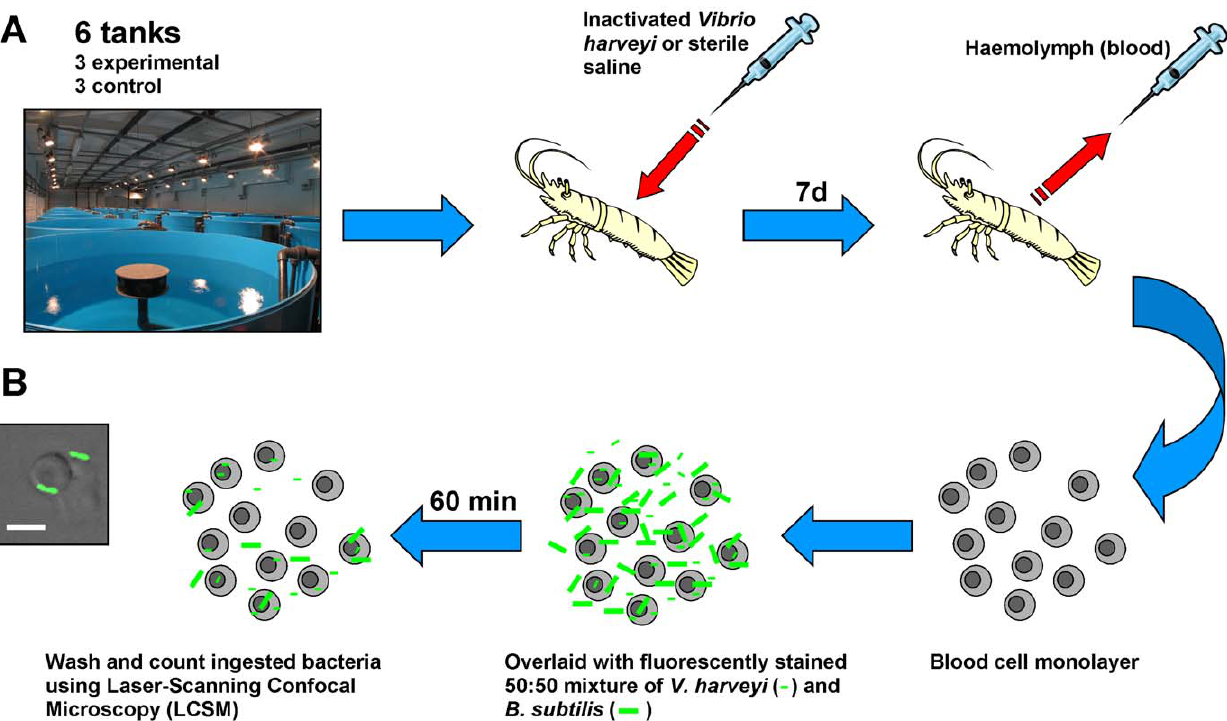
Figure 1. Experimental design for phagocytosis experiments. (A) Schematic diagram of experimental design. Juvenile shrimp ( L. vannamei ) were assigned randomly across 6 6 1500L tanks and injected with either formalin-inactivated Vibrio harveyi (a known shrimp pathogen; 10 8 bacteria animal 2 1 ) or sterile 3% NaCl solution (12–14 animals tank 2 1 , 3 tanks treatment 2 1 ). After 7 d, monolayers of shrimp haemocytes were overlaid with a mixture of fluorescently-labelled formalin-inactivated V. harveyi and an unrelated bacterium ( Bacillus subtilis ; 50:50 mixture). The ability of the haemocytes to phagocytose the different bacteria was then investigated using LSCM. (B) High-power LSCM projection of 15 optical sections through a shrimp haemocyte (total z -axis=10.4 m m) and four FITC-labelled Bacillus subtilis bacteria. Whether an individual bacteria is internalised or not can be determined through sequential viewing of each optical section. Scale bar=5 m m.